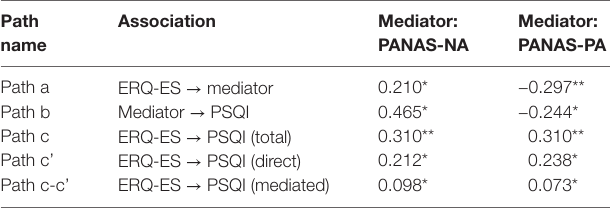
TABLE 2 | Positive and negative affect as mediators between expressive suppression and sleep quality.